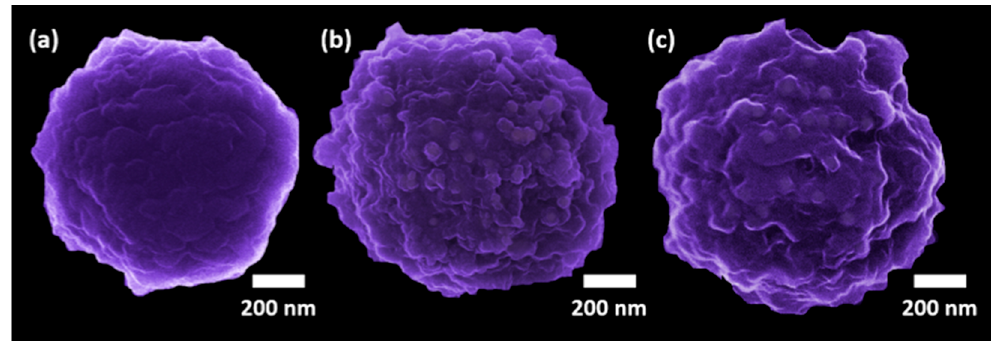
Figure 3. Images of the magnetic beads generated by HIM after conjugation with antibody ( a ), after exposure to wastewater effluent ( b ), and after the exposure to standard HAdV-5 sample ( c ).